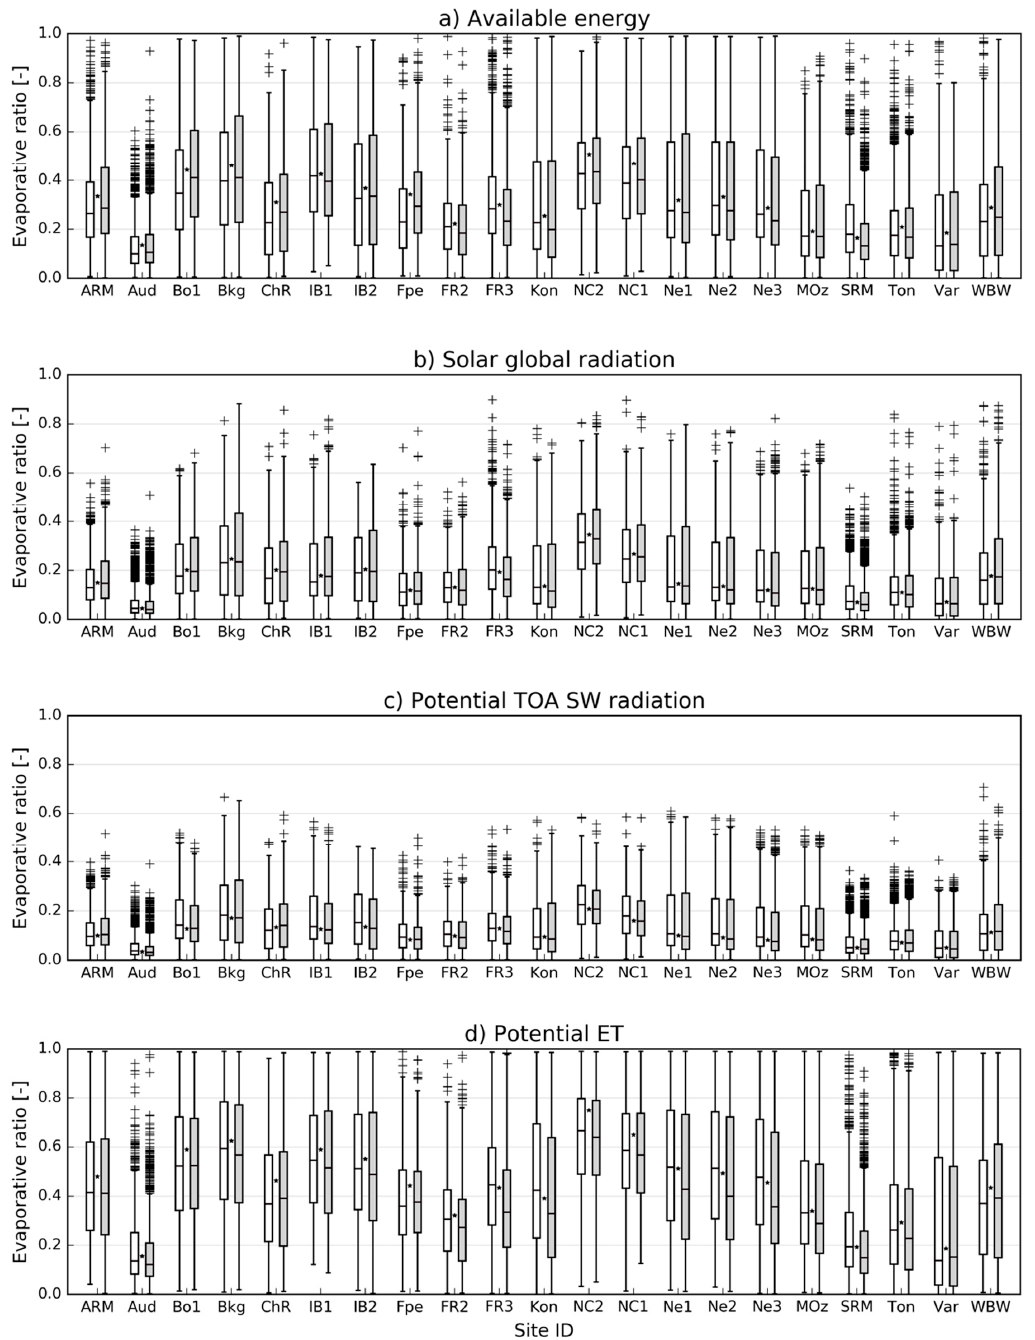
Figure 3. Distribution of the evaporative ratios derived for each site and two times of day, 10:00 (white boxes) and 13:00 (gray boxes) based on four different scaling reference fluxes: ( a ) Available energy, ( b ) top-of-canopy incoming shortwave (SW) radiation, ( c ) modelled top-of-atmosphere (TOA) incoming SW radiation, and ( d ) potential ET. The boxes extend from the lower to upper quartile values of the data, with a line at the median. The whiskers represent 1.5 interquartile range below and above the boxes. For each site, the star symbols between boxes represent the median evaporative ratios derived from daytime average ET measured by the station and scaling fluxes. The AmeriFlux site ID labels are defined in Table 2. Following [36,45], we derived β factors using in situ flux data (Equation (4)) to evaluate the performance of the different scaling methods and verify the assumption of a constant evaporative